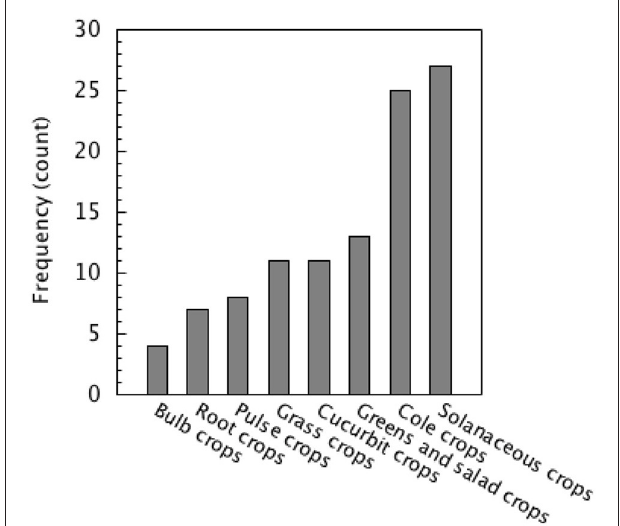
FIGURE 1 | Frequency of various vegetable crops that were evaluated in the literature; classified according to use, botany or a combination of use/botany.